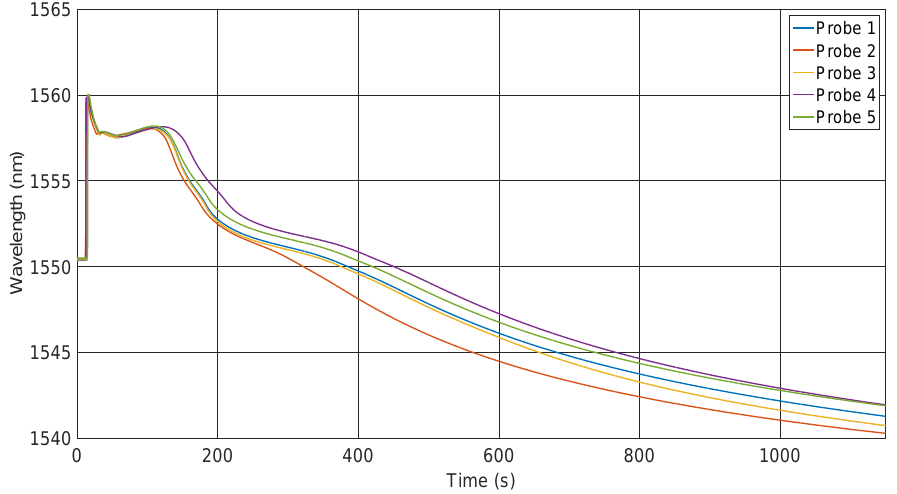
Figure 7. Peak wavelength of the reflected spectra of the FBGs across the flow